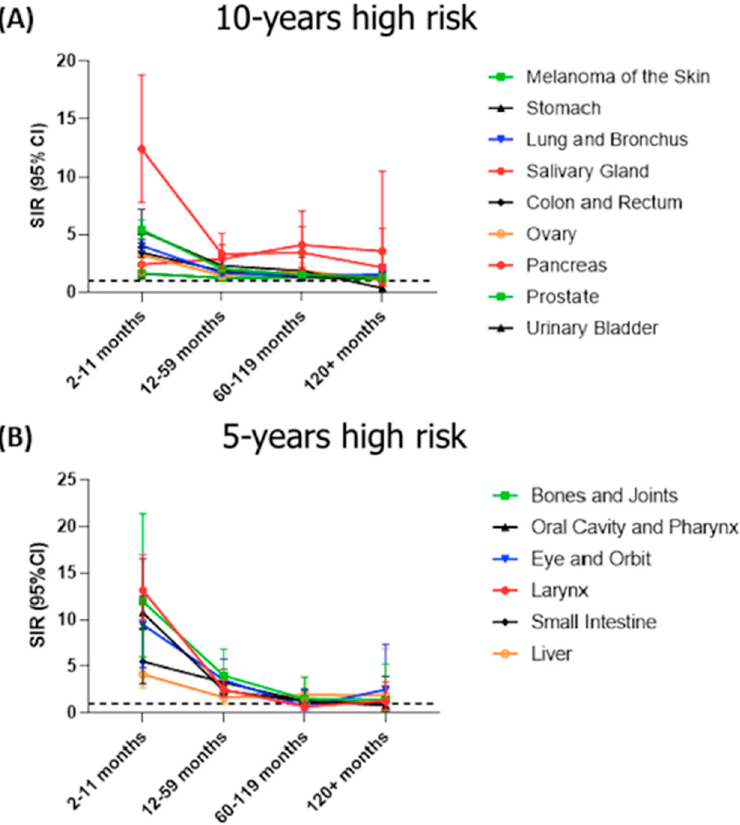
Figure 4. Latency course of elevated SIRs of developing second primary thyroid cancer risk in patients according to selected primary cancer. Primary cancers which mantained increased risk at ( A ) 10-years and at ( B ) 5-years. SIR: standardized incidence ratio (observed/expected), CI: confidence interval.